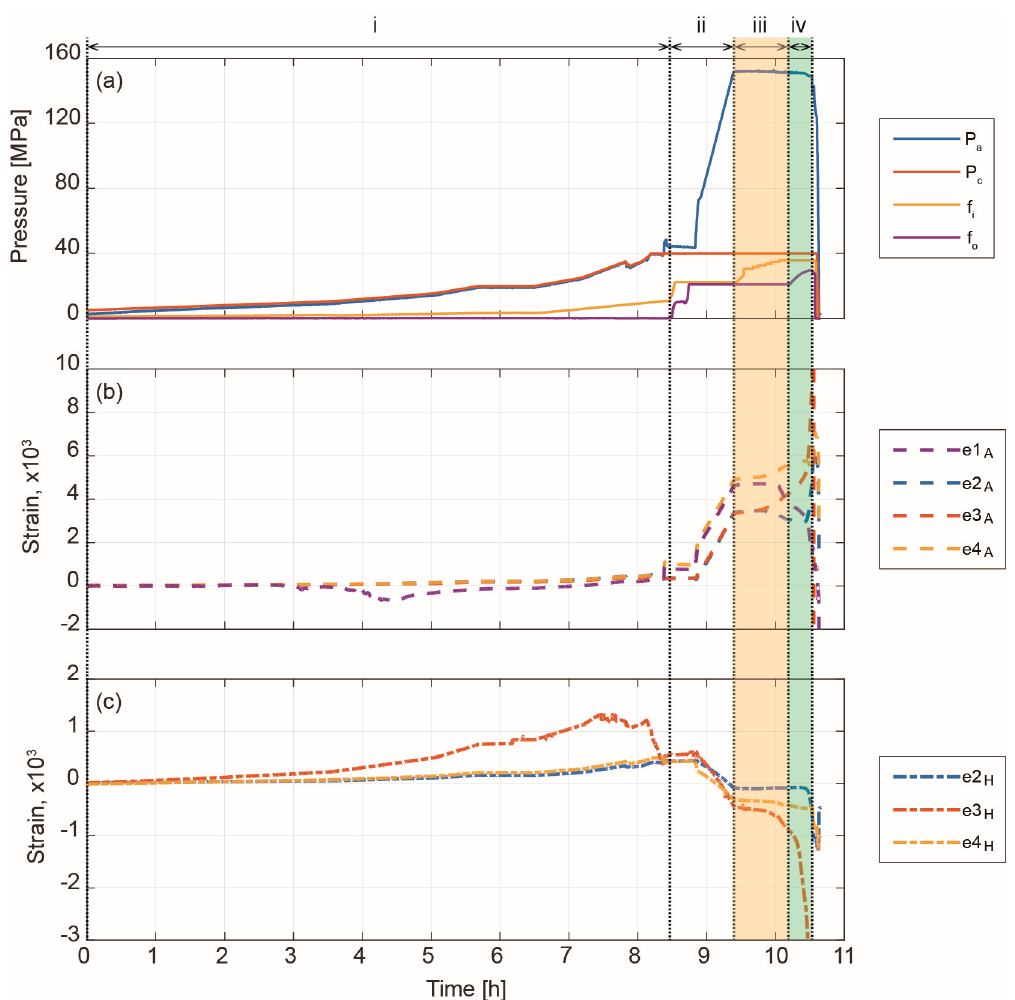
Figure 5. Stress loading and water injection processes for the sample, and the plots of strain curves. ( a ) Numbers i–iv indicate loading and injection stages. P a and P c represent axial stress and confining pressure, respectively. f i and f o represent injection pressure from pump A and pump B, respectively; ( b ) Axial strains monitored by sensor e1–e4; ( c ) Circumferential strains monitored by sensor e2–e4, and the e1 H was broken or shorted before the test.